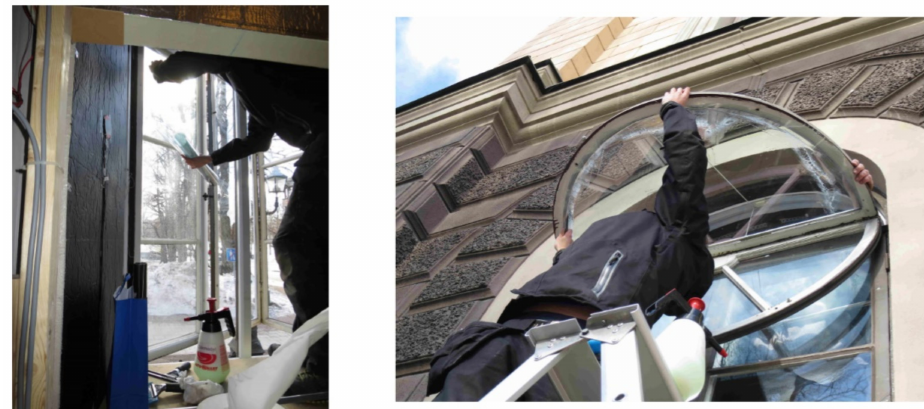
Figure 7. Installation of the low-E window film on surface 3 [33].